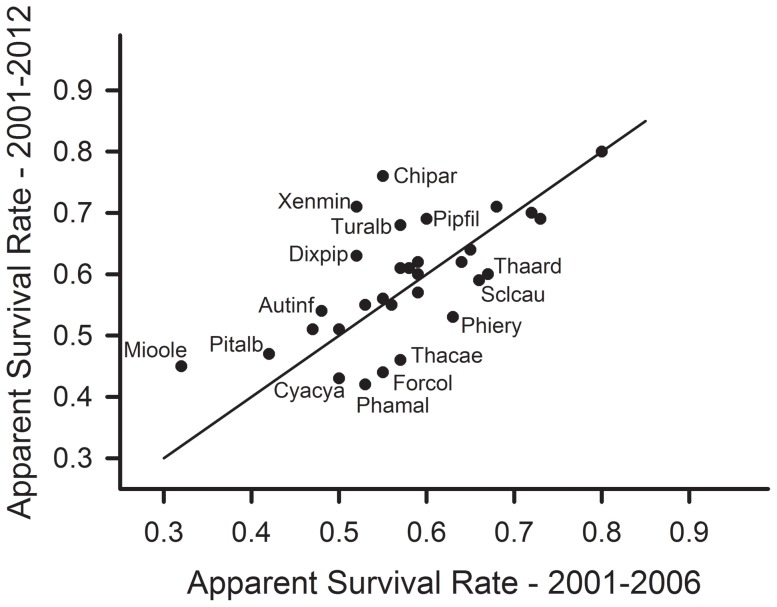
Estimates of apparent survival for 31 species based on 6 or 12 years of data.Estimates of apparent survival were calculated from capture and recapture data gathered at Tiputini Biodiversity Station, Ecuador. Estimates shown are for the most highly supported model. Straight line indicates equal estimates between the two sets of data. Species showing substantial differences between sets: Autinf – Automolus infuscatus; Chipar – Chiroxiphia pareola; Cyacya – Cyanocompsa cyanoides; Forcol – Formicarius colma; Mioole – Mionectes oleagineus; Phamal – Phaethornis malaris; Phiery – Philydor erythrocercum; Pipfil – Pipra filicauda; Dixpip – Dixiphia pipra; Pitalb - Pithys albifrons; Sclcau – Sclerurus caudacutus; Thaard - Thamnomanes ardesiacus; Thacae – Thamnomanes caesius; Turalb – Turdus albicollis; Xenmin – Xenops minutus.